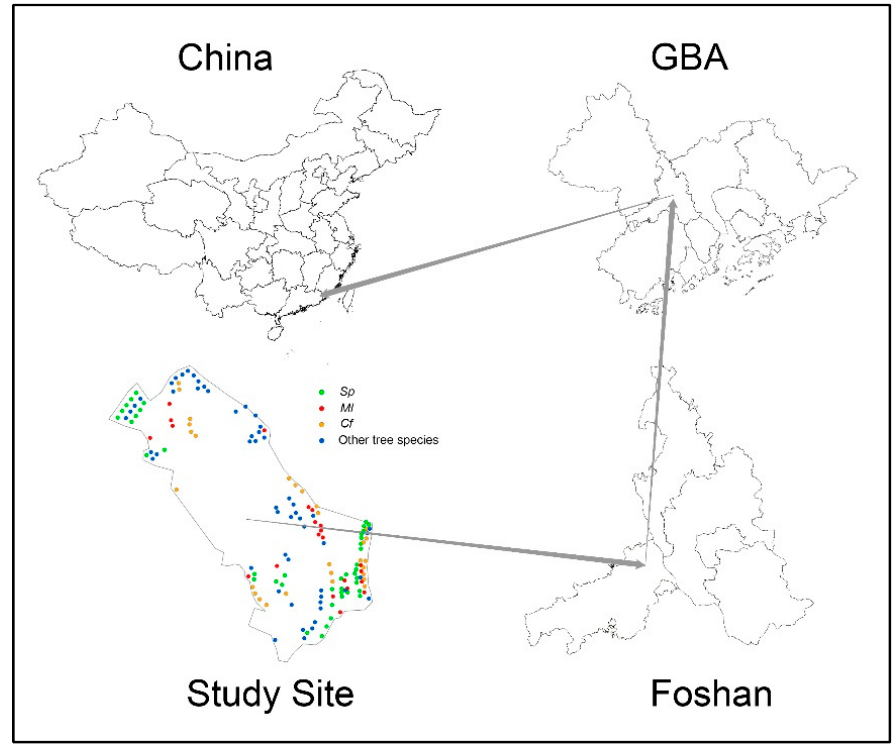
Figure 1. Illustration of study site in Foshan of GBA, China. The green, red and yellow points represent Sp , Ml and Cf , respectively while the blue ones are the other tree species.